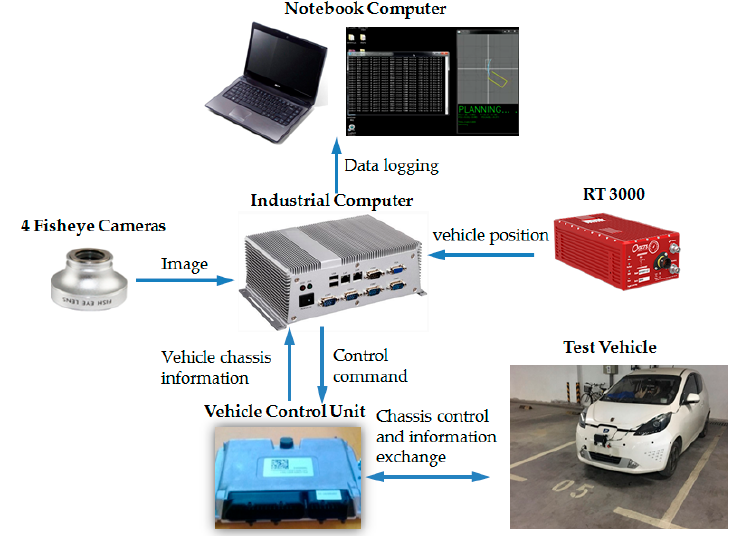
Figure 17. Experimental platform.